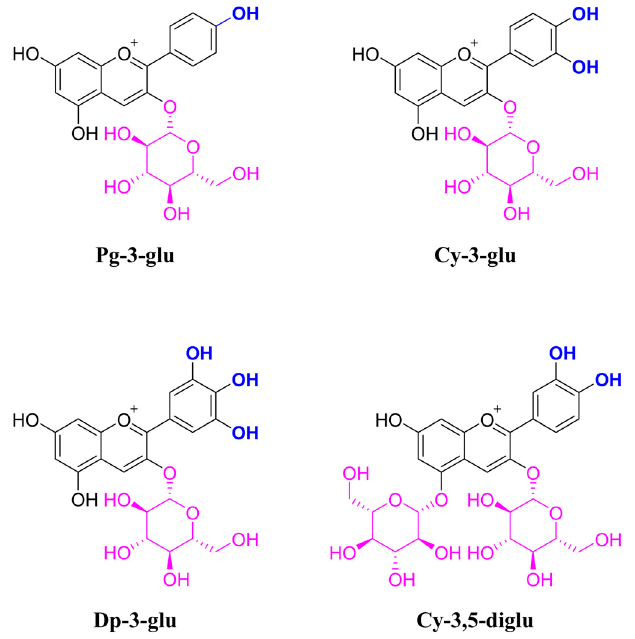
Figure 1. Molecular structures of four anthocyanins, Pg-3-glu, Cy-3-glu, Dp-3-glu, and Cy-3,5-diglu.